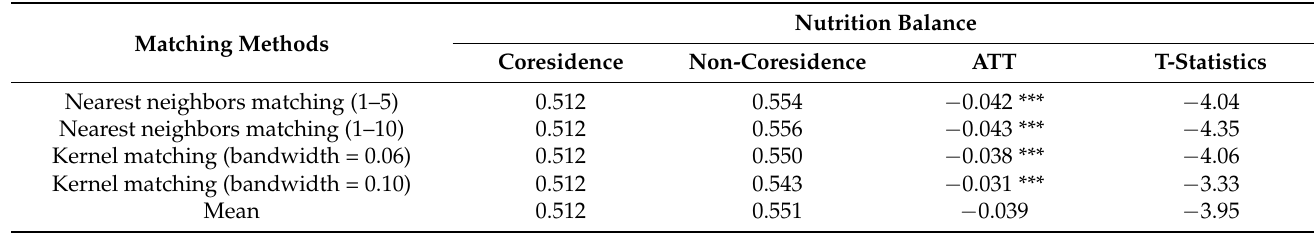
Table 7. Effect of grandparents’ coresidence on children’s and adolescents’ nutrition